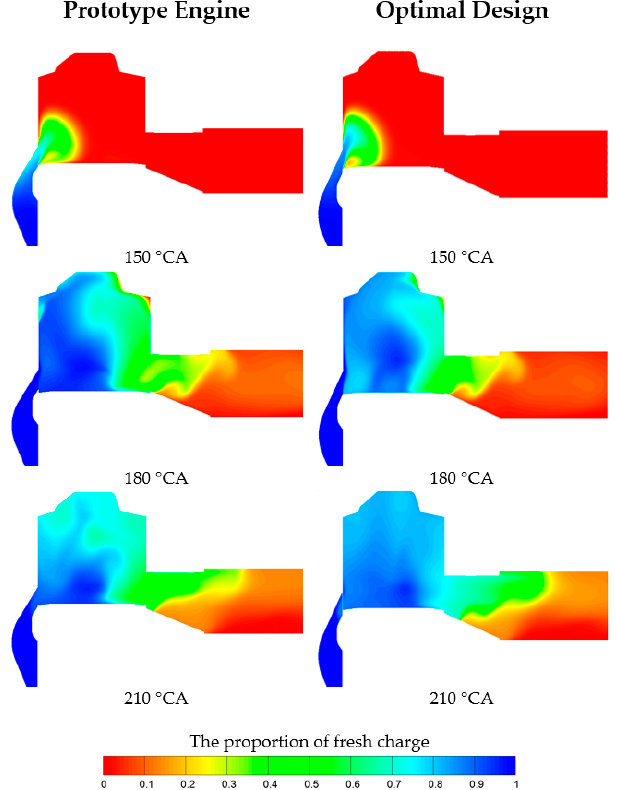
Figure 21. X cross-sectional views of the prototype engine simulation case and optimal design simulation case under the high load operating condition.